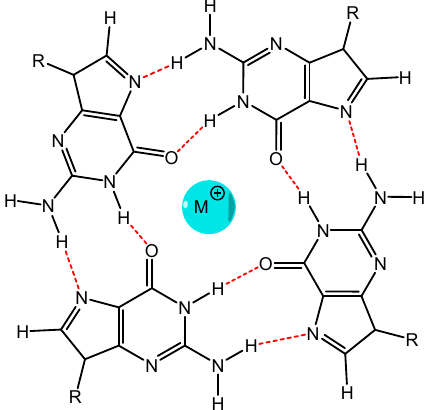
Figure 15. The G-quadruplex structure.